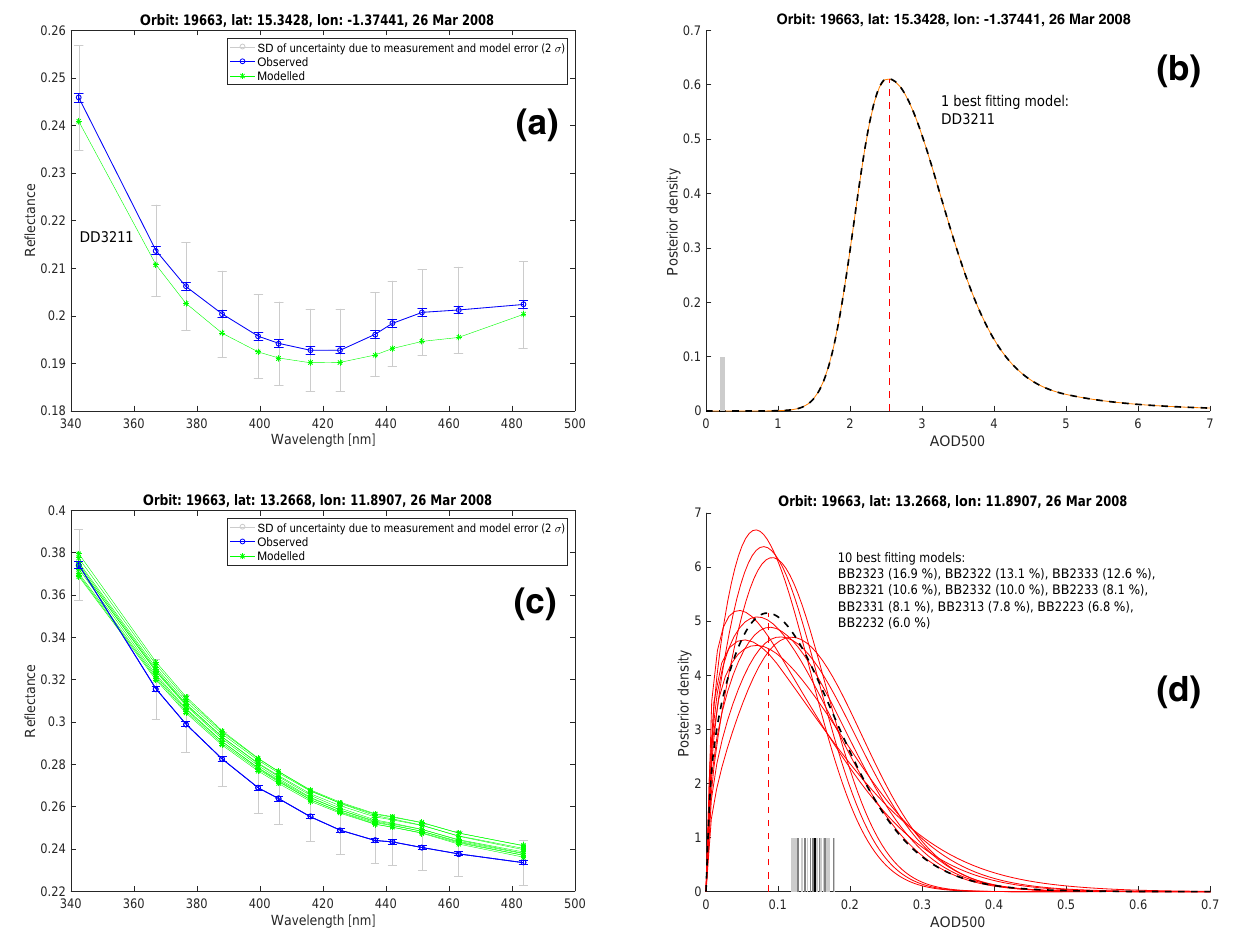
Figure 14. Same as Fig. 7 but for the pixels located at Agoufou (a, b) and DMN_Maine_Soroa (c, d) . The grey vertical lines show AERONET version 2 direct-sun level 2 AOD at 500nm values. The darker grey vertical lines (d) denote AERONET AOD values within a 2h time window including OMI overpass time and the black vertical line is the average of these